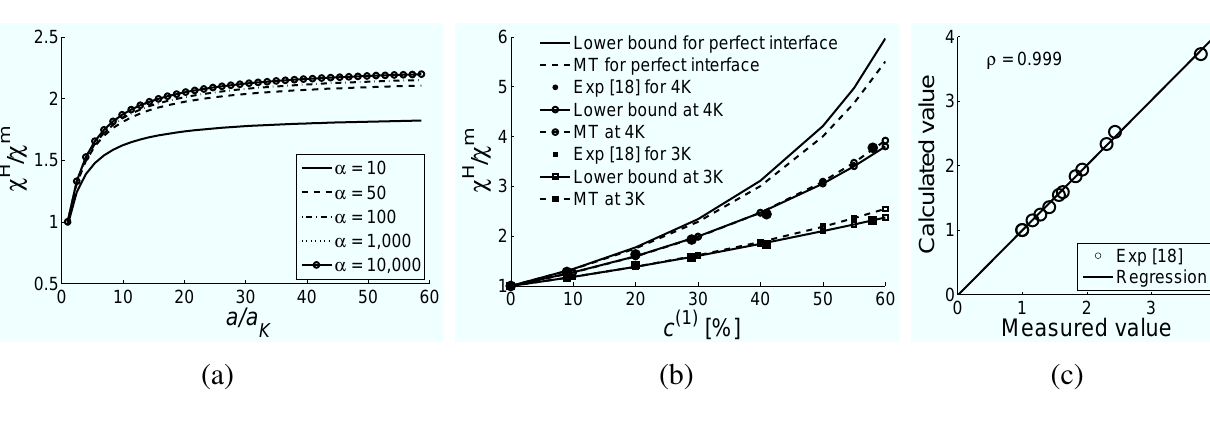
( c (1) = 30% ) and ( b ) volume K